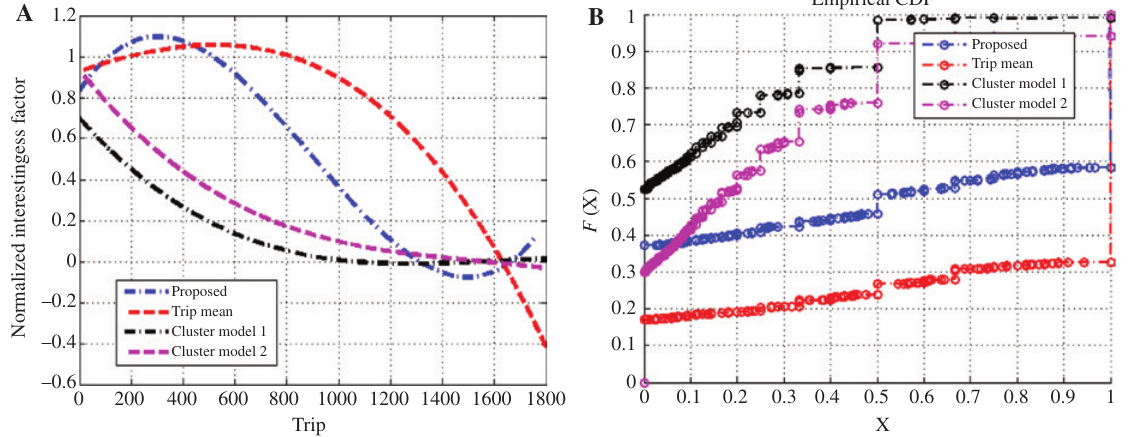
Figure 8: Performance Comparison Using (A) Normalized Interestingness Factor Over Every Trip Plan and (B) Its Distribution for 20%